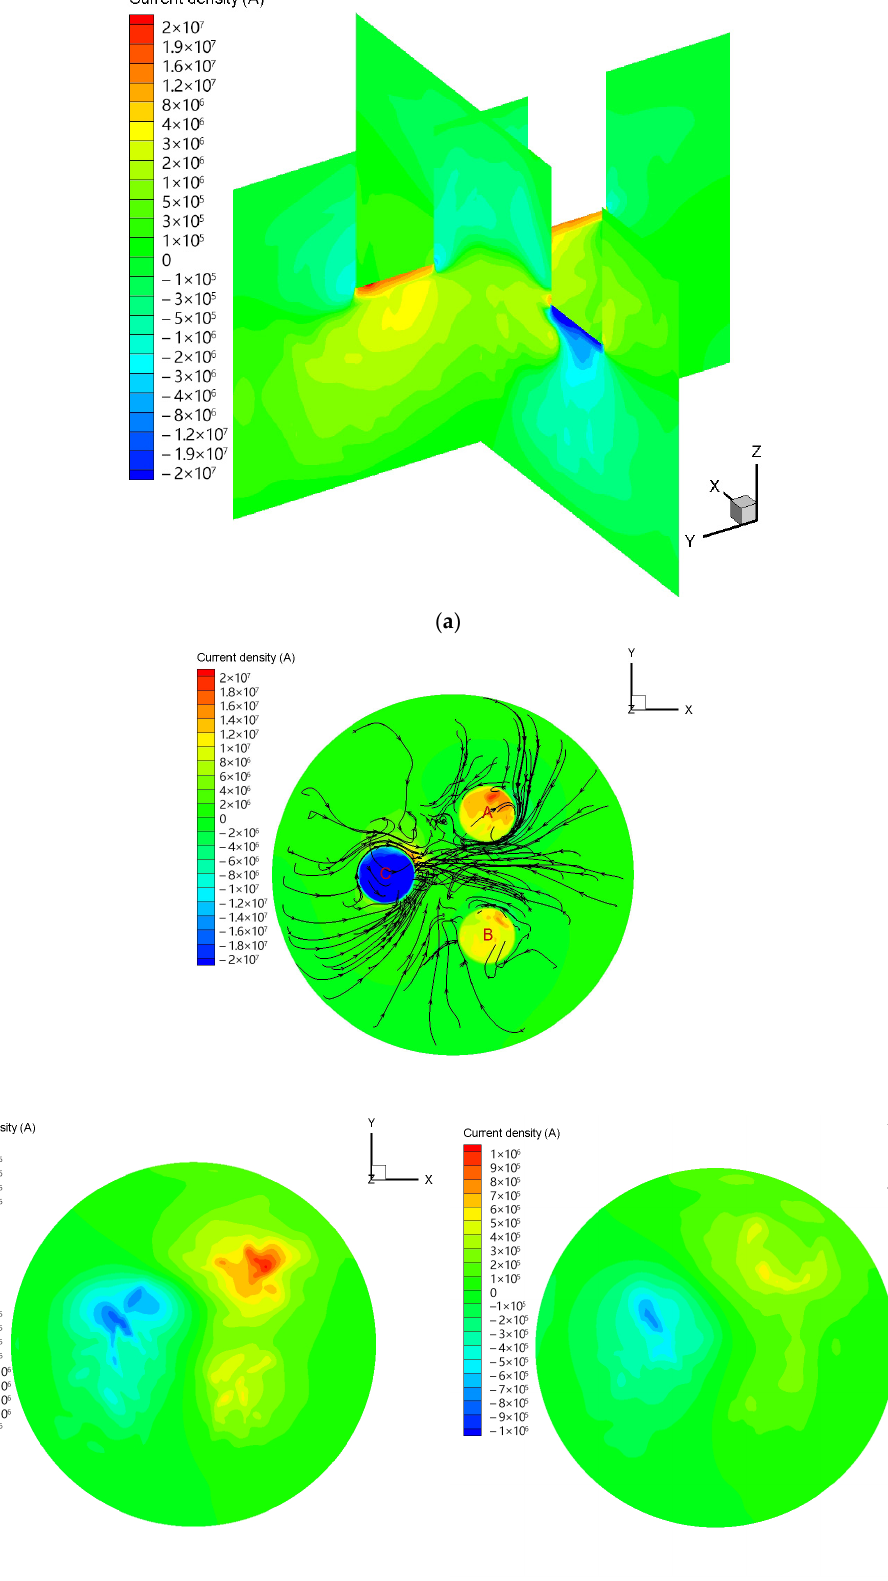
Figure 6. ( a ) Current density and flow direction (longitudinal section). ( b ) z = 0.65 m, 0.35 m, 0.15 m current densities and flow directions (cross ‐